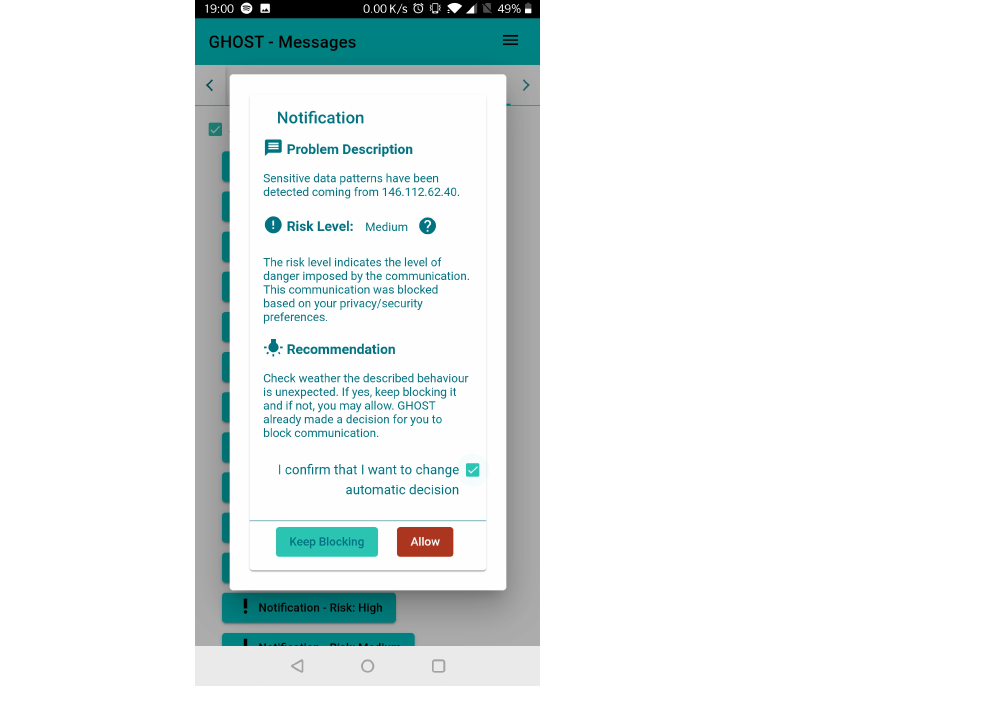
Figure 14. Notification of automated